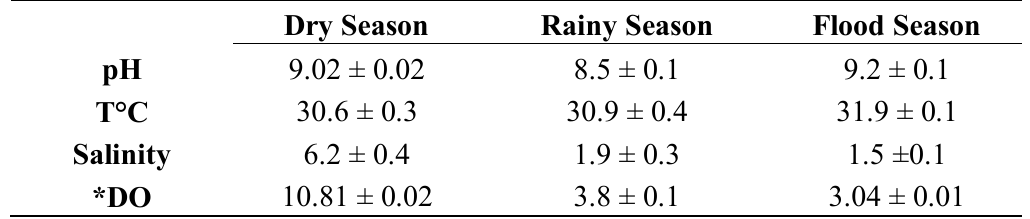
Table 2. Physicochemical parameters in the Aby lagoon during